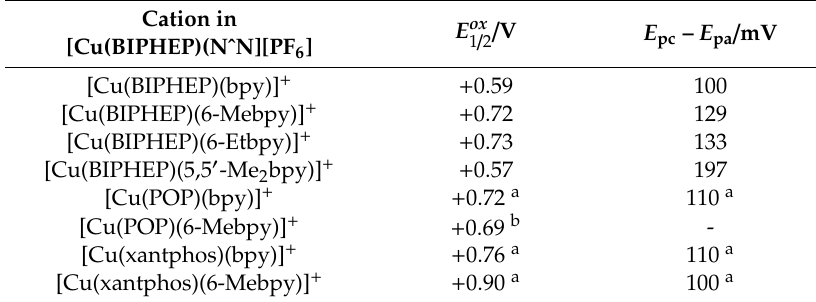
Table 2. Cyclic voltammetric data for [Cu(BIPHEP)(NˆN)][PF 6 ] complexes referenced to internal Fc / Fc + = 0.0 V; CH 2 Cl 2 (dried) solutions, with [ n Bu 4 N][PF 6 ] as the supporting electrolyte and a scan rate of 0.1 V s − 1 . Processes are quasi-reversible.